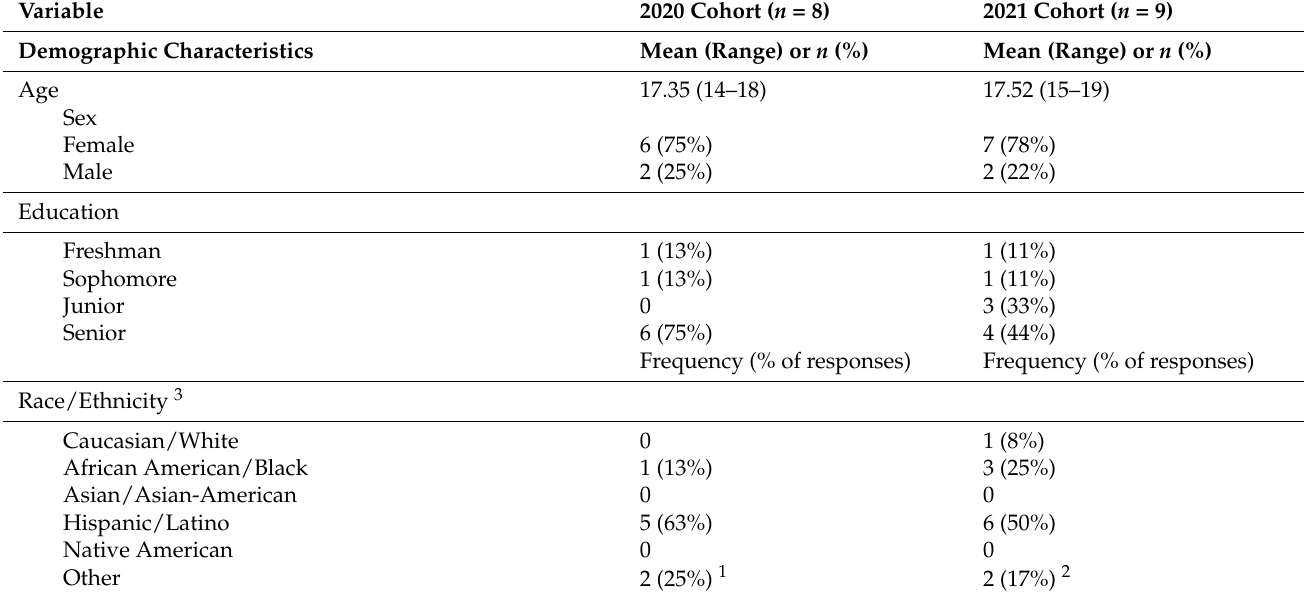
Table 3. MINT 2020 and 2021 Cohort Demographics and Loneliness